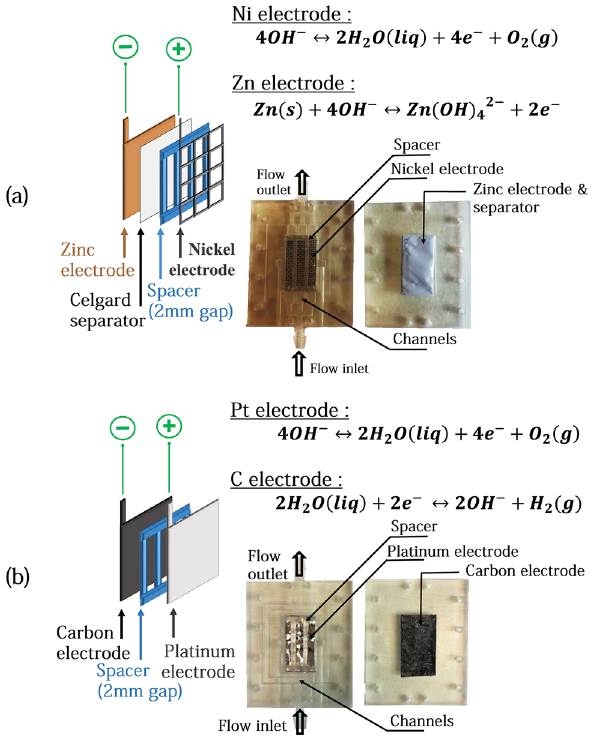
Figure 1. Sketches of the two systems studied. ( a ) Zinc Cell and its components. ( b ) Electrolysis Cell and its components.